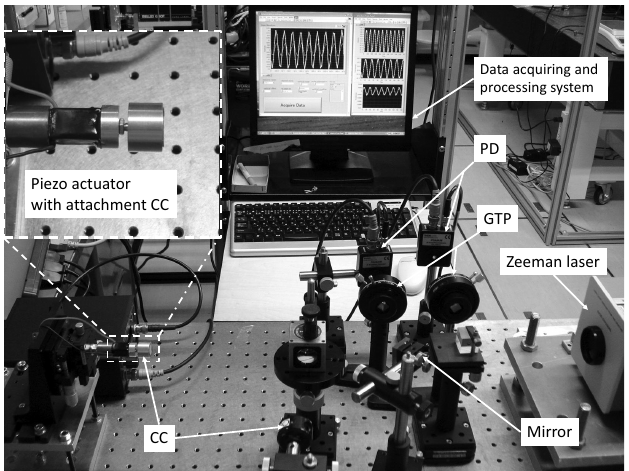
Figure 2. Photographs of measurement